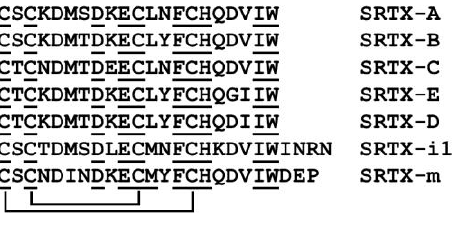
Figure 3. Amino acid sequences of sarafotoxins. Disulfide bonds are shown as lines connecting cysteine residues. Identical amino acid residues are underlined. SRTX-A (UniProtKB-P13208), SRTX-B (P13208), SRTX-C (P13208), SRTX-E (P13208), and SRTX-D (P13211) are sarafotoxins a, b, c, e, and d from A. engaddensis venom, respectively. SRTX-i1 (P0DJK0) is sarafotoxin i1 from A. irregularis venom; SRTX-m (Q6RY98) is sarafotoxin m from the venom of A. microlepidota microlepidota . Endothelin signaling through endothelin type B receptors (ET B R) participates in in- creasing neuronal activity. Therefore, the activation of ET B R on sympathetic nerves would increase blood pressure through an adrenergic-mediated mechanism. To determine the pressor response to the selective ET B R agonist sarafotoxin c (S6c), ET B R deficient rats, which express functional ET B R only on adrenergic neurons, have been used [123]. A dose- dependent pressor response to S6c in ET B R- deficient rats is reversed by prazosin, an α1 - adrenergic receptor antagonist, and is augmented by propranolol, a β -adrenergic receptor antagonist. Heart rate is mostly unaffected by S6c alone or by S6c with either prazosin or propranolol. These results suggest that ET B R activation on sympathetic neurons induces an increase in blood pressure mediated through α1 -adrenergic receptor signaling [123]. Most of the works on sarafotoxins were published at the end of the last century. Thus, it was found that 125 I-sarafotoxin-b recognized sites in rat brain, particularly in the cere- bellum (K D = 3.5 nM) and cerebral cortex (K D = 0.3 nM) [124]. Sarafotoxins possess strong cardiotoxic activity resulting in atrio-ventricular block in vertebrates. Impairment of an electrical signal from the heart atria to the ventricles is varied dependently on a species [125]. Sarafotoxin-6B increased [Ca 2+ ]i in individual cerebellar astrocytes in cell culture through activation of endothelin receptors. Ca 2+ influx was predominantly non-voltage- dependent, although some entry through a dihydropyridine-sensitive pathway also ap- peared to occur. [126]. All of these data suggest the presence of molecular targets in excit- able tissues, including neurons, that may be encountered along signal propagation path- ways. Presently, sarafotoxins are used as biochemical tools to study endothelin receptors. So, to clarify the recognition mechanism of the endothelin-like peptide family, a crystal structure of the human ET B R in complex with sarafotoxin S6b was determined [127]. The data about neurotoxins discussed in this review are summarized in the table (Ta- ble 1). Table 1. Neurotoxins identified in hemotoxic venoms. Name